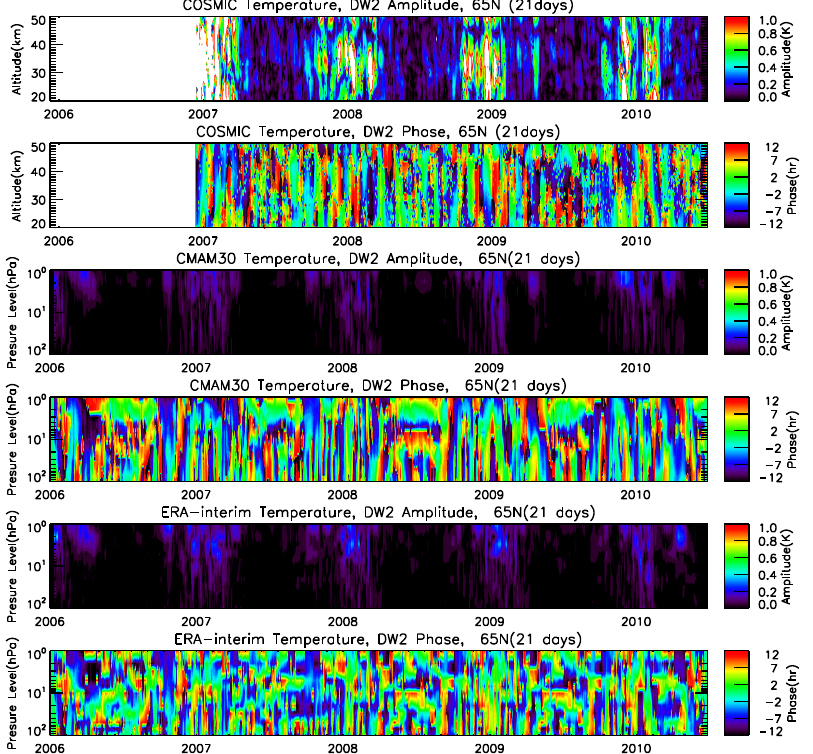
Figure 4. Amplitudes and phases of DW2 tide over 65 ◦ N from COSMIC observations, CMAM30, and ERA-interim reanalysis datasets using ± 10-day